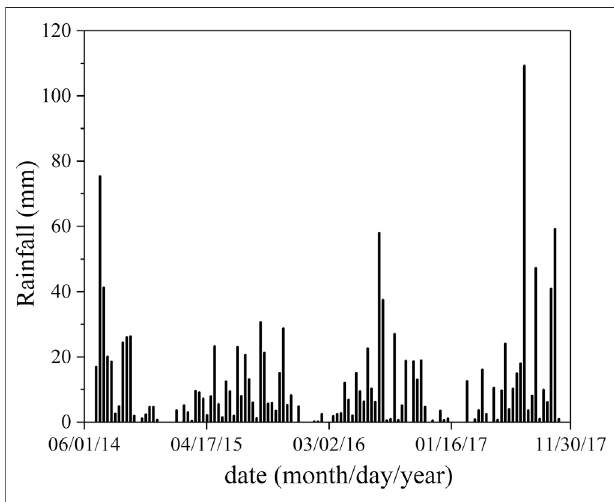
FIGURE 2 | Evolution of daily rainfall for the study area from 2014 to 2017.